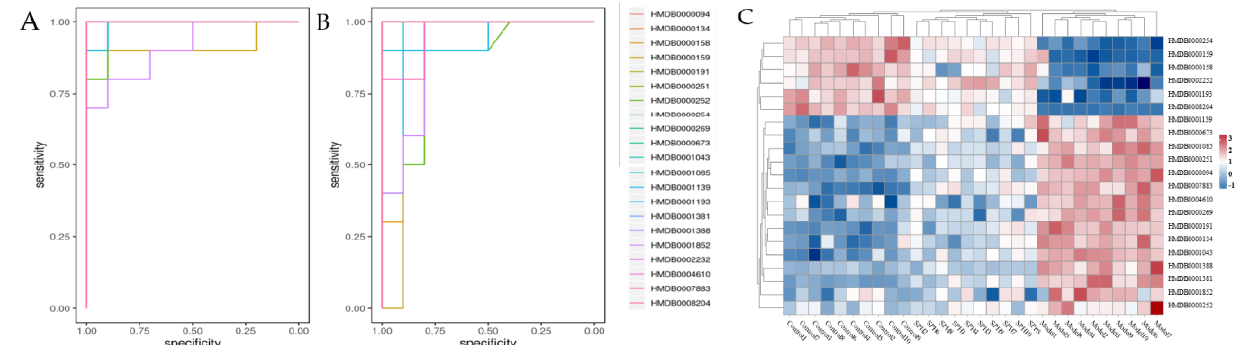
Figure 9. The predictive receiver operating characteristic (ROC) curves ( A : between control group and model group, B : between model group and SPH group) and the heatmap ( C ) of the identified potential biomarkers in each group.